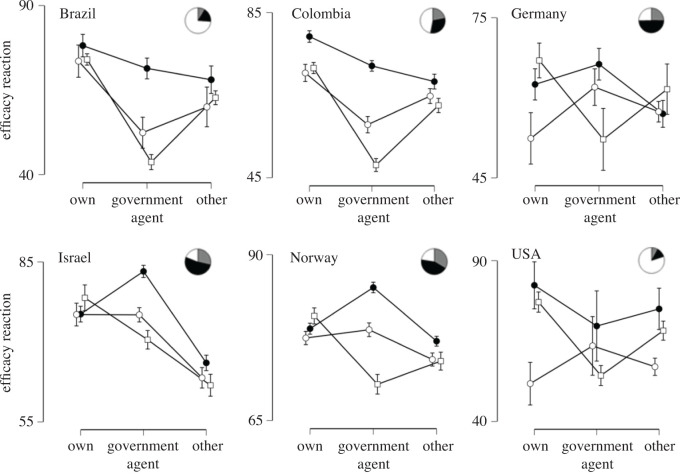
Perceived efficacy of reactions per country and action. Filled circles and black in the pie chart inserts: participants were satisfied with how their country fought the outbreak; white circles and grey in pie chart inserts: participants stating do not know whether their country does enough; white squares and white pie: participants were not satisfied.